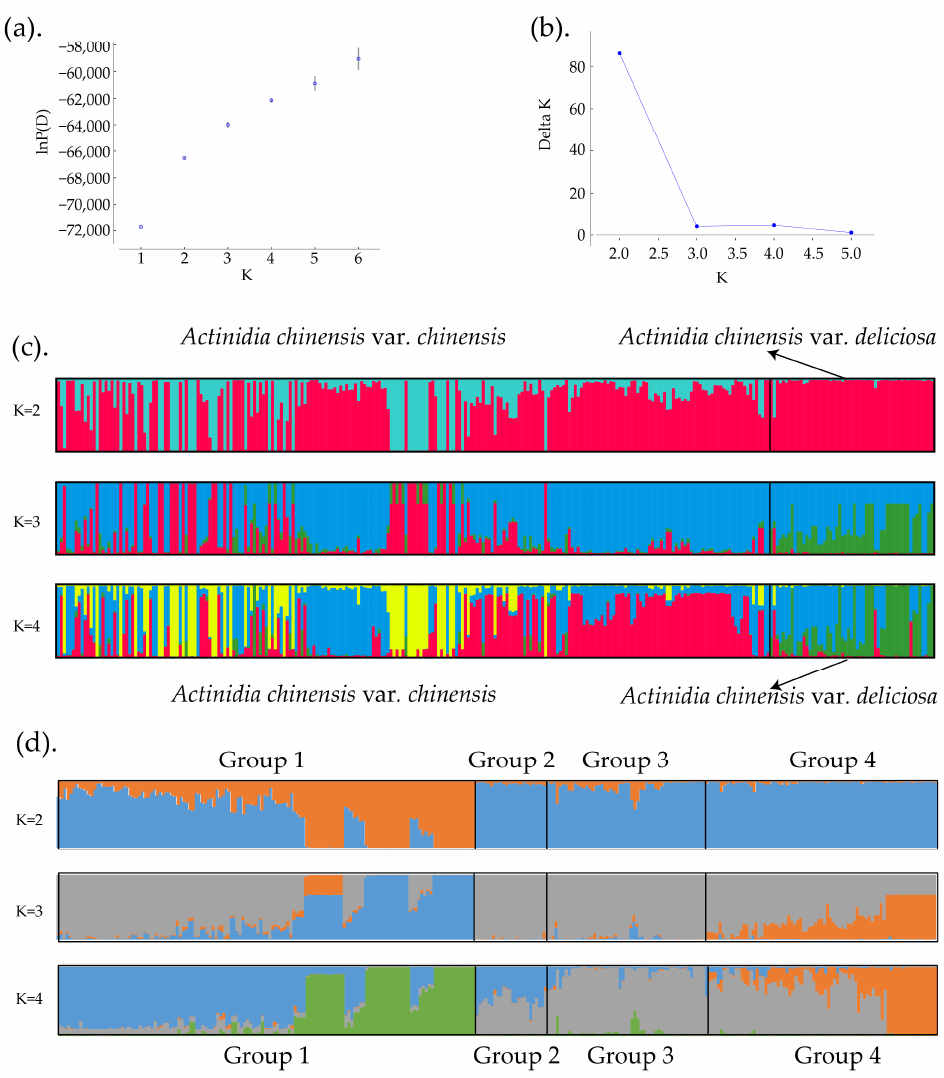
Figure 2. Population structure analysis of the A. chinensis complex. ( a ) Based on the average value of lnP(D), draw the subgroup grouping scatter diagram. ( b ) Based on ∆ K value, draw subgroup grouping scatter diagram. ( c ) When K = 2~4, the genetic structure of the A. chinensis var. chinensis and A. chinensis var. deliciosa . ( d ) When K = 2~4, the genetic structure of the group1~group4 germplasm. Each color in the ( c , d ) represents a genetic cluster.